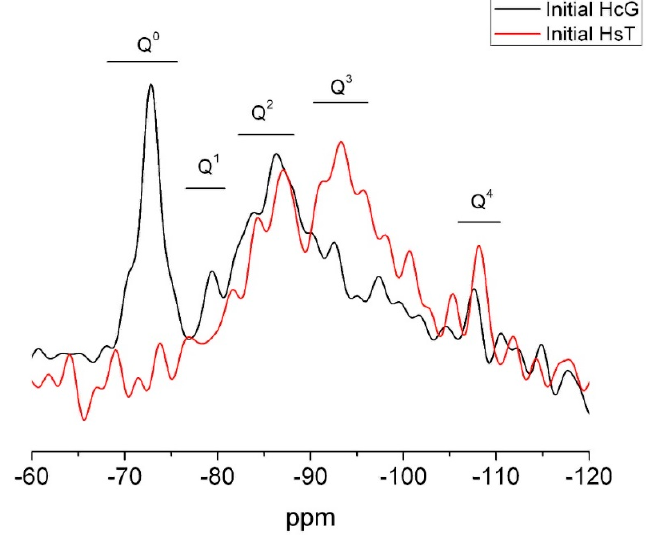
Figure 7. 29 Si NMR spectrum for initial wastes HsT and HcG.